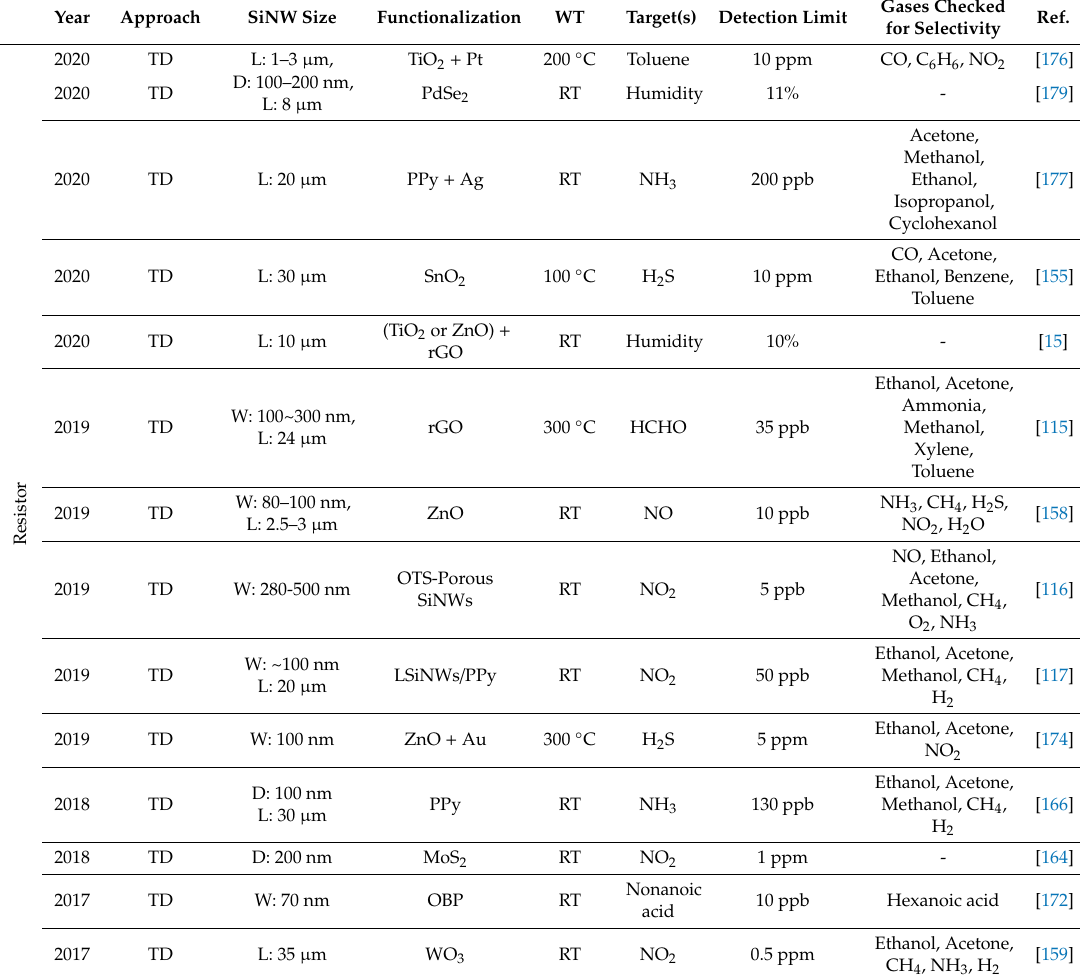
Gases Checked for Selectivity